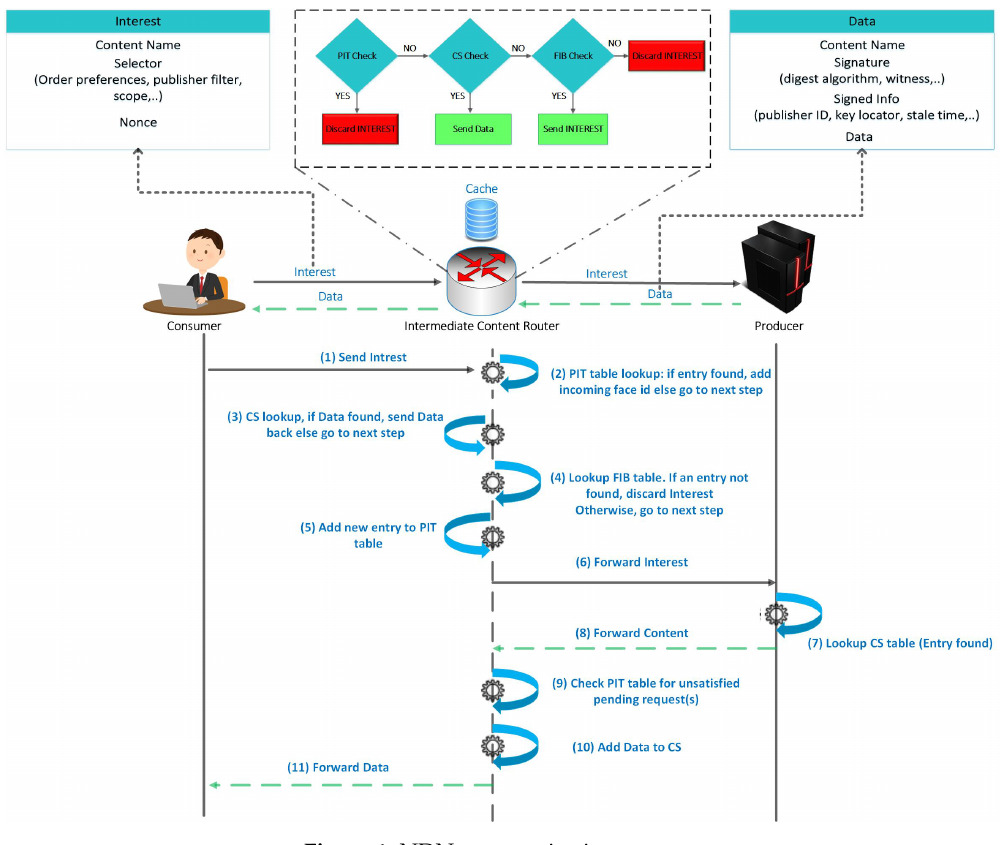
Figure 1. NDN communication